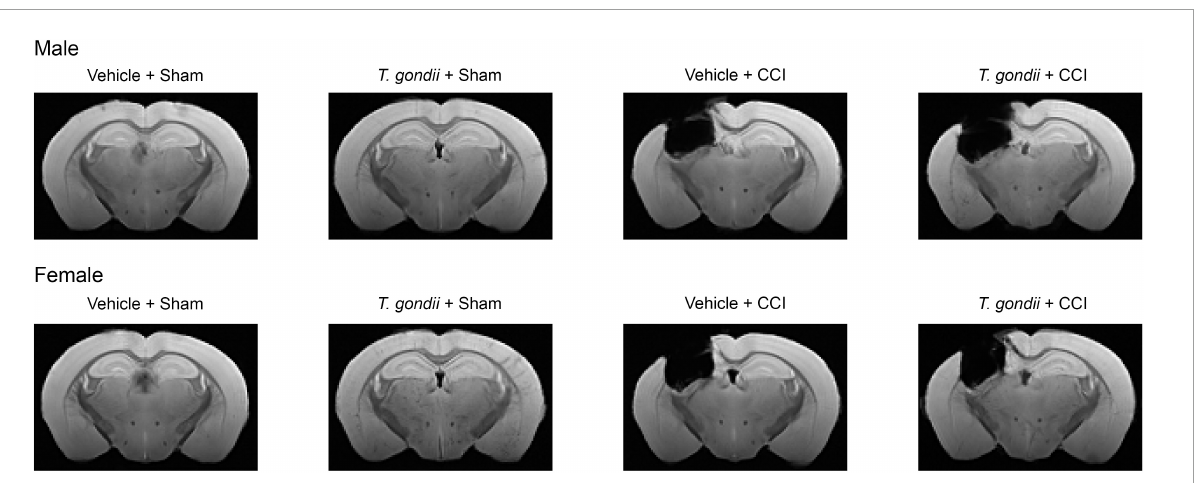
FIGURE2 Controlled cortical impact (CCI) results in long-term structural brain damage. Template structural MRI images show chronic brain damage in CCI groups compared to sham